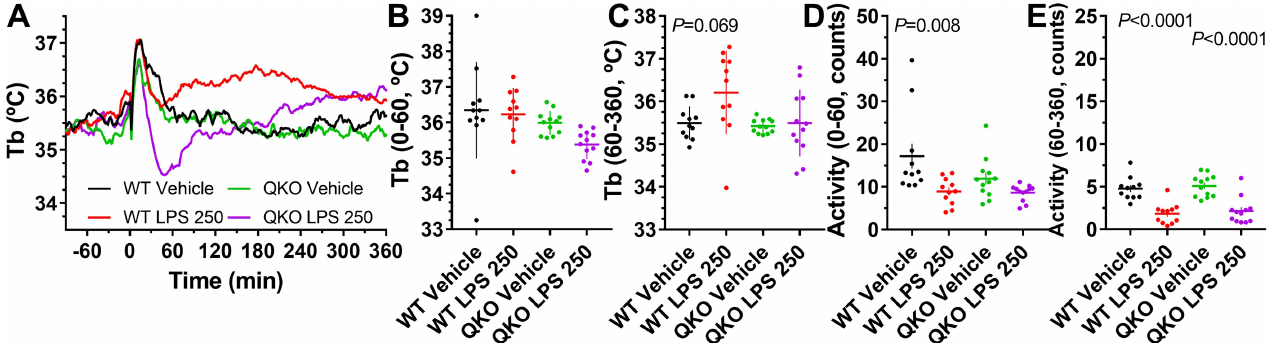
Fig 3. Altered response to LPS in QKO mice. Male QKO and control mice were treated with LPS (250 μ g/kg, i.p.) or vehicle. Adjusted P values (from two-way ANOVA with Tukey multiple comparisons test; N = 11–12/group) are for effect of vehicle versus LPS within genotype (S6 Table). The numerical data are in Supporting information. i.p., intraperitoneal; LPS, lipopolysaccharide; QKO, quad knockout; Tb, core body temperature; WT, wild-type.